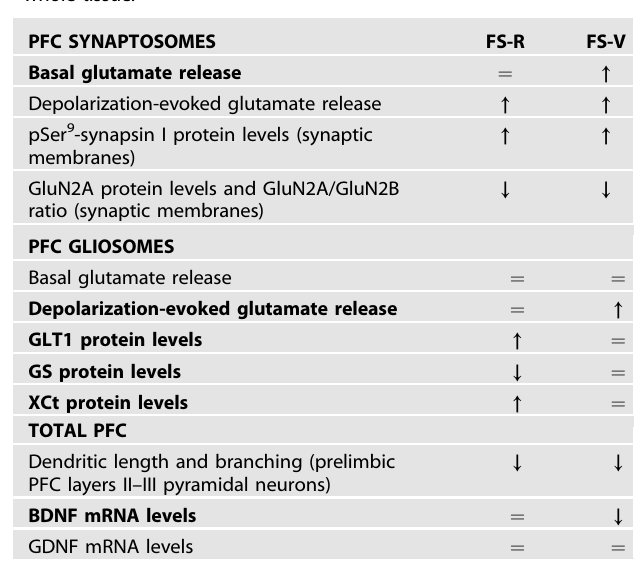
Fig. 6 Expression of astrocytic proteins related to glutamate homeostasis in PFC gliosomes. A Glutamate transporter-1 (GLT1), ( B ) glutamine synthetase (GS), and ( C ) cystine/glutamate antiporter (xCt) protein expression in PFC gliosomes. A one-way ANOVA, Holm- Š ídák